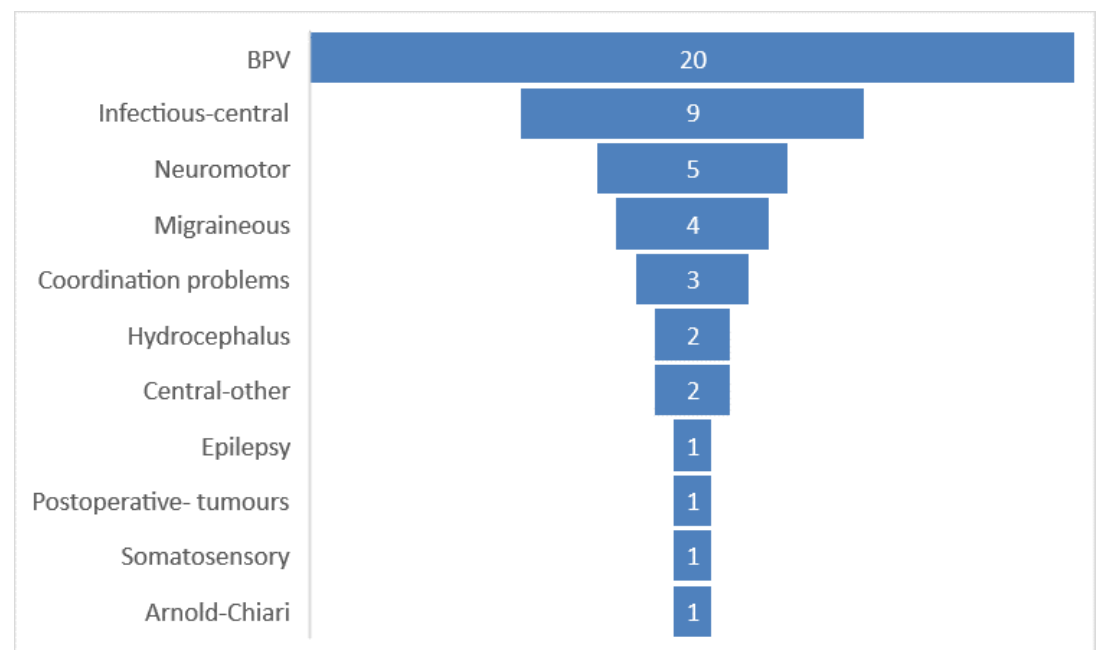
Figure 6. Different central pathologies found in our children. The graph shows the number of each central pathology of vertigo and dizziness.